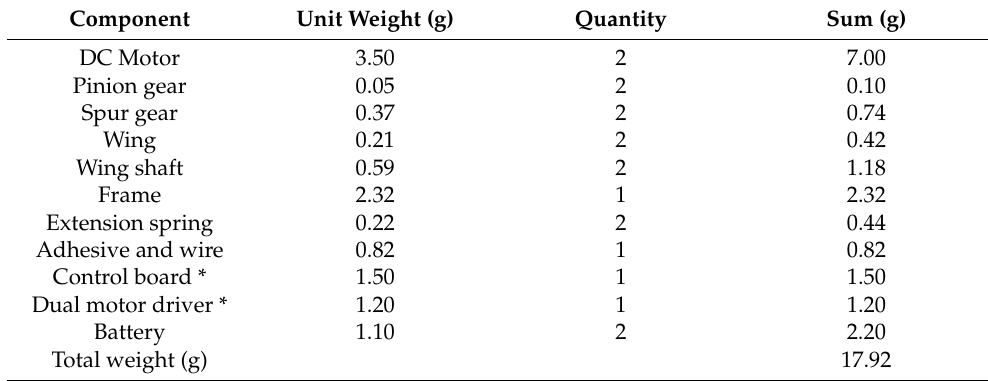
Table 1. Weight of each component.